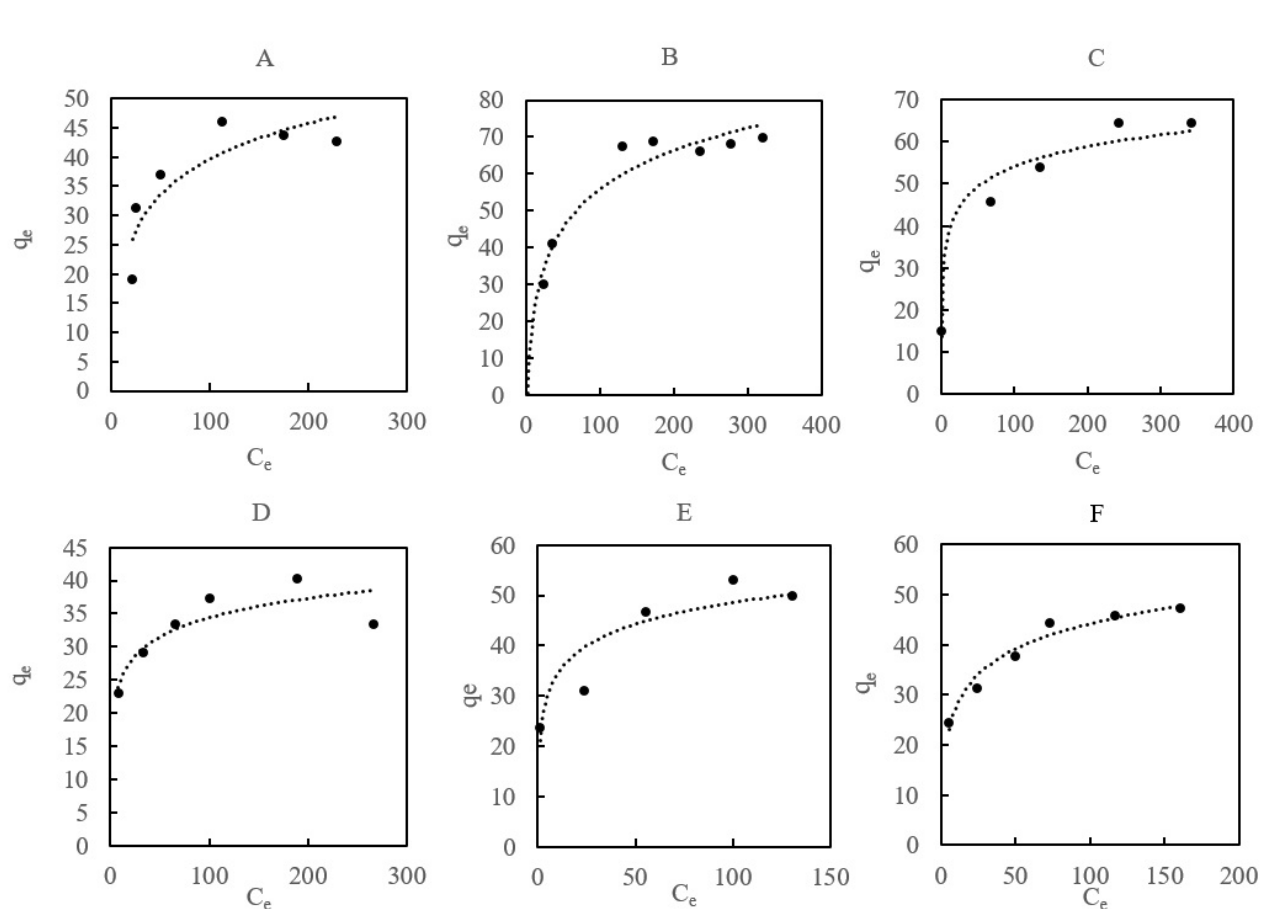
TABLE II - Adsorption constants for SY, AR and FG on Fe